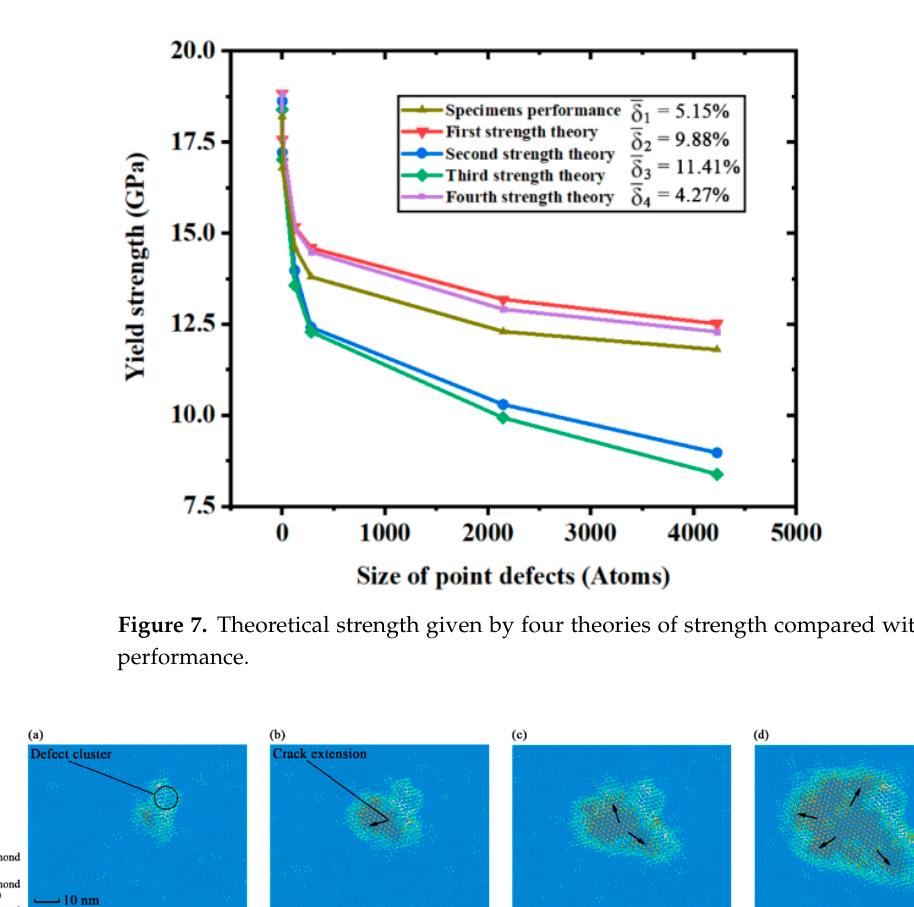
Figure 7. Theoretical strength given by four theories of strength compared with actual specimen performance.